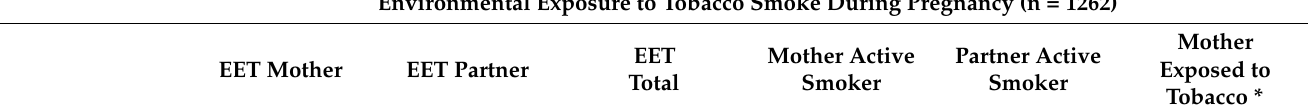
Table 4. Risk assessment (OR) of effects in pregnancy and adverse events in the newborn in relation to the